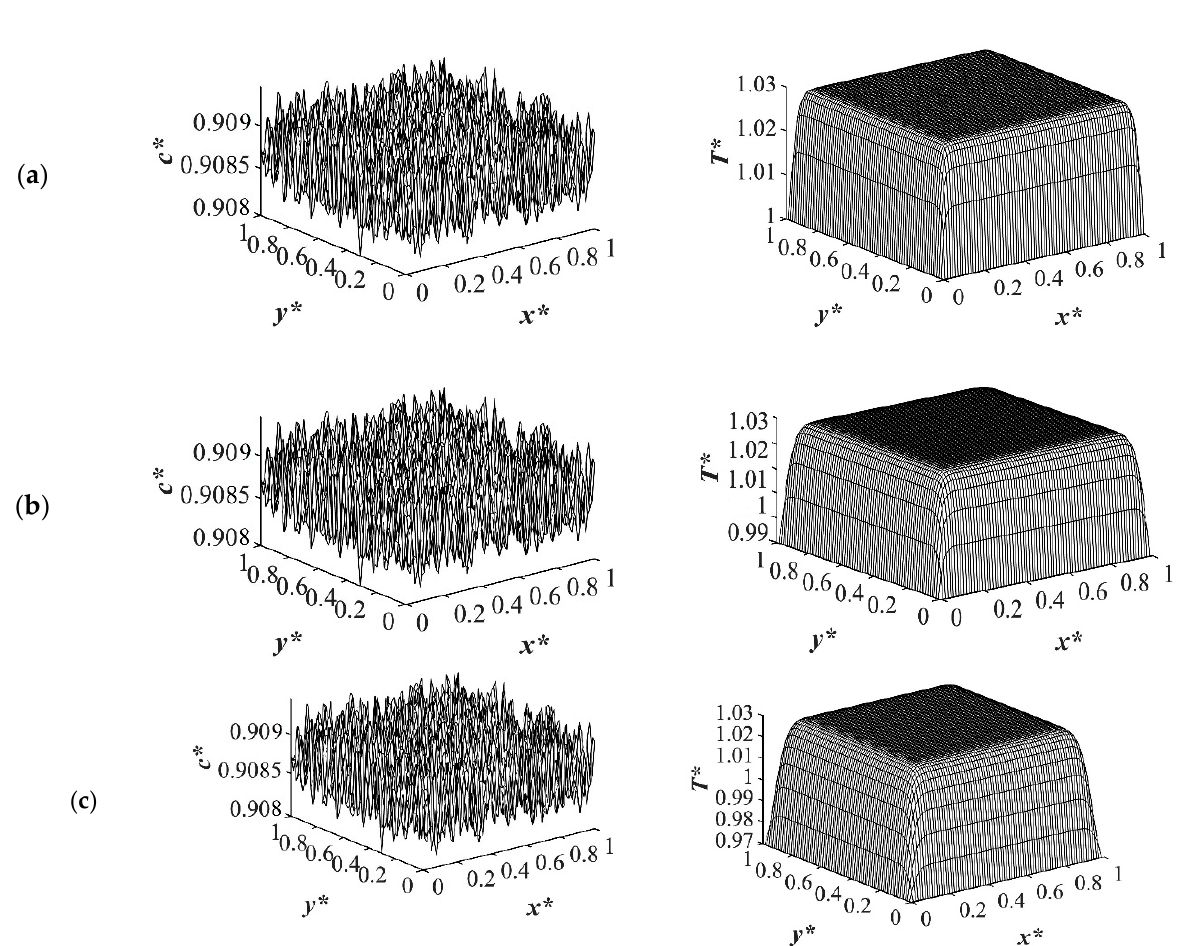
Figure 6. Spatial concentration ( left column) and temperature ( right column) profiles for the off- critical quench to c * = 0.909 at t * = 1.03 × 10 − 6 for three different quench depths of ( a ) T * q1 = 1.0, ( b ) T * q2 = 0.99 ( c ) T * q3 = 0.97.